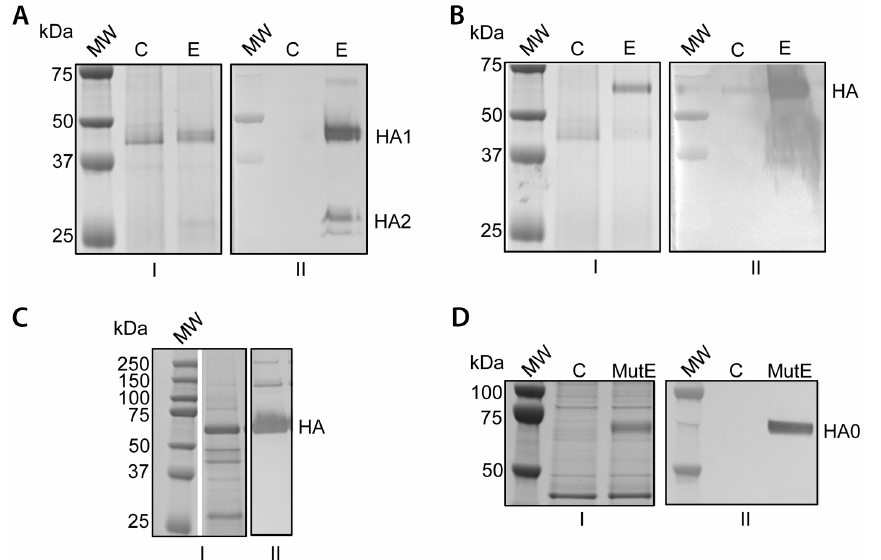
Figure 1. Production of hemagglutinin from Influenza strain A/Puerto Rico/8/34 by Schizochytrium sp. SDS-PAGE analysis of cell-free supernatants under reducing (A and D) and non-reducing (B and C) conditions and corresponding immunoblots with anti-Influenza A virus antibody are shown. Panels ‘‘I’’ are gels stained with Coomassie blue and panels ‘‘II’’ are the corresponding immunoblots. (A) Analysis of cell-free supernatants from Schizochytrium control ‘‘C’’ and experimental ‘‘E’’ strains showing the presence of HA subunits 1 and 2 under reducing conditions HA1 and HA2). (B) Analysis of cell-free supernatants from Schizochytrium control ‘‘C’’ and experimental ‘‘E’’ strains showing the presence of HA under non-reducing conditions. (C) SDS-PAGE analysis (non-reducing) of the Schizochytrium HA fraction used for the mouse challenge study. (D) Analysis of cell-free supernatants from Schizochytrium control ‘‘C’’ and mutant experimental ‘‘MutE’’ strains showing the presence of an uncleaved form of HA (HA0) under reducing conditions.